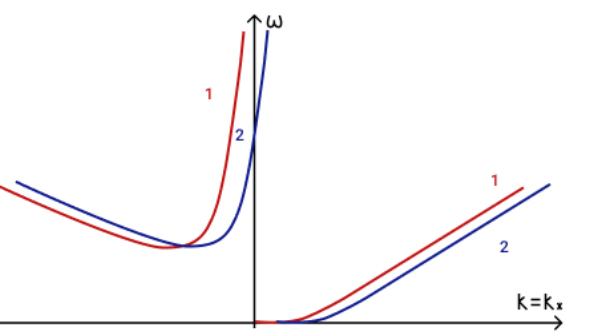
Figure 11. Phase matching condition for three magneto-Rossby waves: 1— ω = ω mr 1 ( k x ) , 2— ω = ω mr 1 ( k x − k x